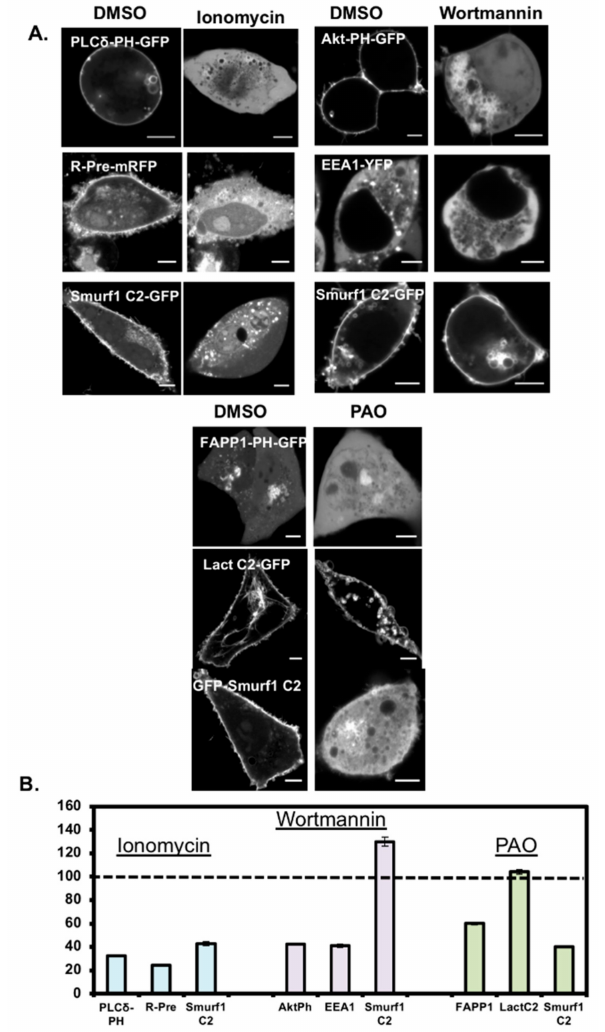
Figure 5. Pharmacological modulation of cellular lipids supports the interaction of Smurf1 C2 with cellular phosphoinositides. ( A ) Ionomycin treatment disrupts the normal localization of Smurf1 C2, PLC δ -PH and R-pre PM, causing the rapid translocation of Smurf1 C2 away from the plasma membrane of CHO-K1 cells (images were taken 2 min after ionomycin treatment). In contrast, wortmannin did not cause any significant dissociation of Smurf1 C2 from the plasma membrane in HEK293 cells. Exposure to phenylarsene oxide for 20 min also caused the dissociation of Smurf1 C2 from the plasma membrane, probably due to the loss of PI(4)P, a direct precursor of PI(4,5)P 2 . The Golgi localization of the PI(4)P-binding FAPP1 PH domain was dramatically reduced by treatment with phenylarsene oxide, whereas there was no e ff ect on the PS-binding lactadherin C2. ( B ) Plasma membrane localization was quantified for the Smurf1 C2 domain and lipid reporter constructs for ionomycin, wortmannin, and PAO treatments ( n ≥ 4 for all experiments). Scale bars = 5 µ